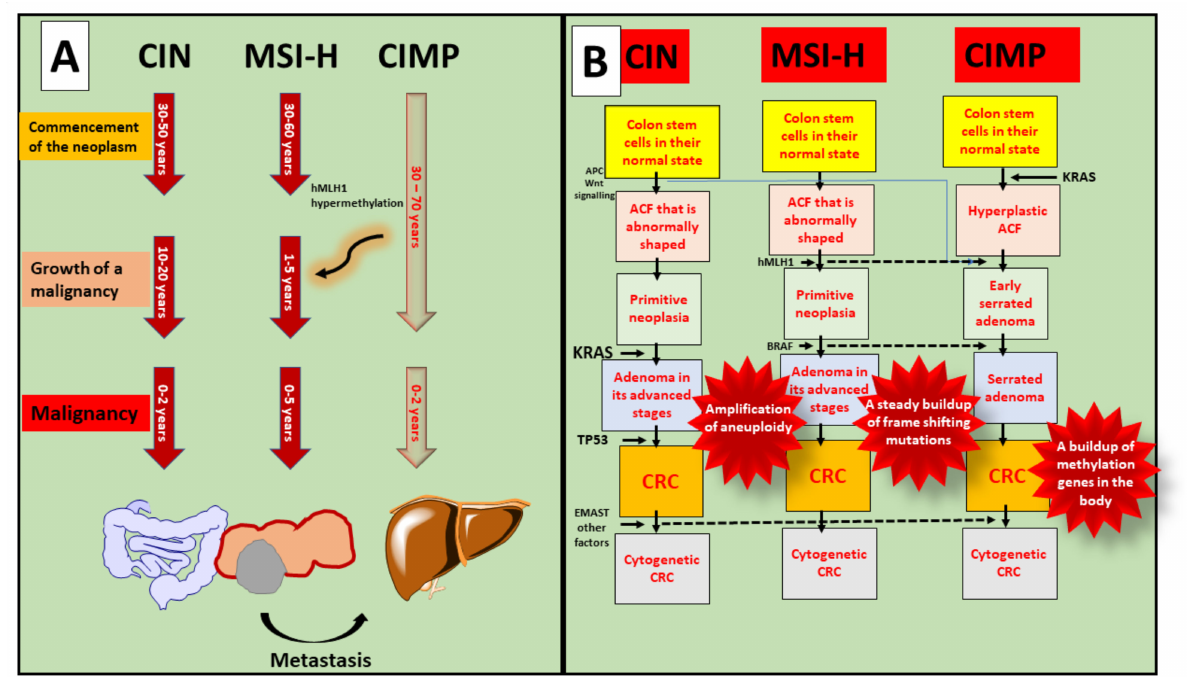
Figure 3. Involvement of MSI, CpG, and CIMP in the progression of CRC. ( A ) Every age groups are susceptible to malignancy, and progression of colorectal cancer shows after the occurrence of metastasis; ( B ) In the case of CIN, various molecular pathways play crucial roles such as Wnt, KRAS, TP53, and EMAST and forms CRC progression. While MSI-H shows progression via hMLH1 and BRAF. Whereas, CIMP is interconnected with KRAS mutation and causes cytogenetic to normal